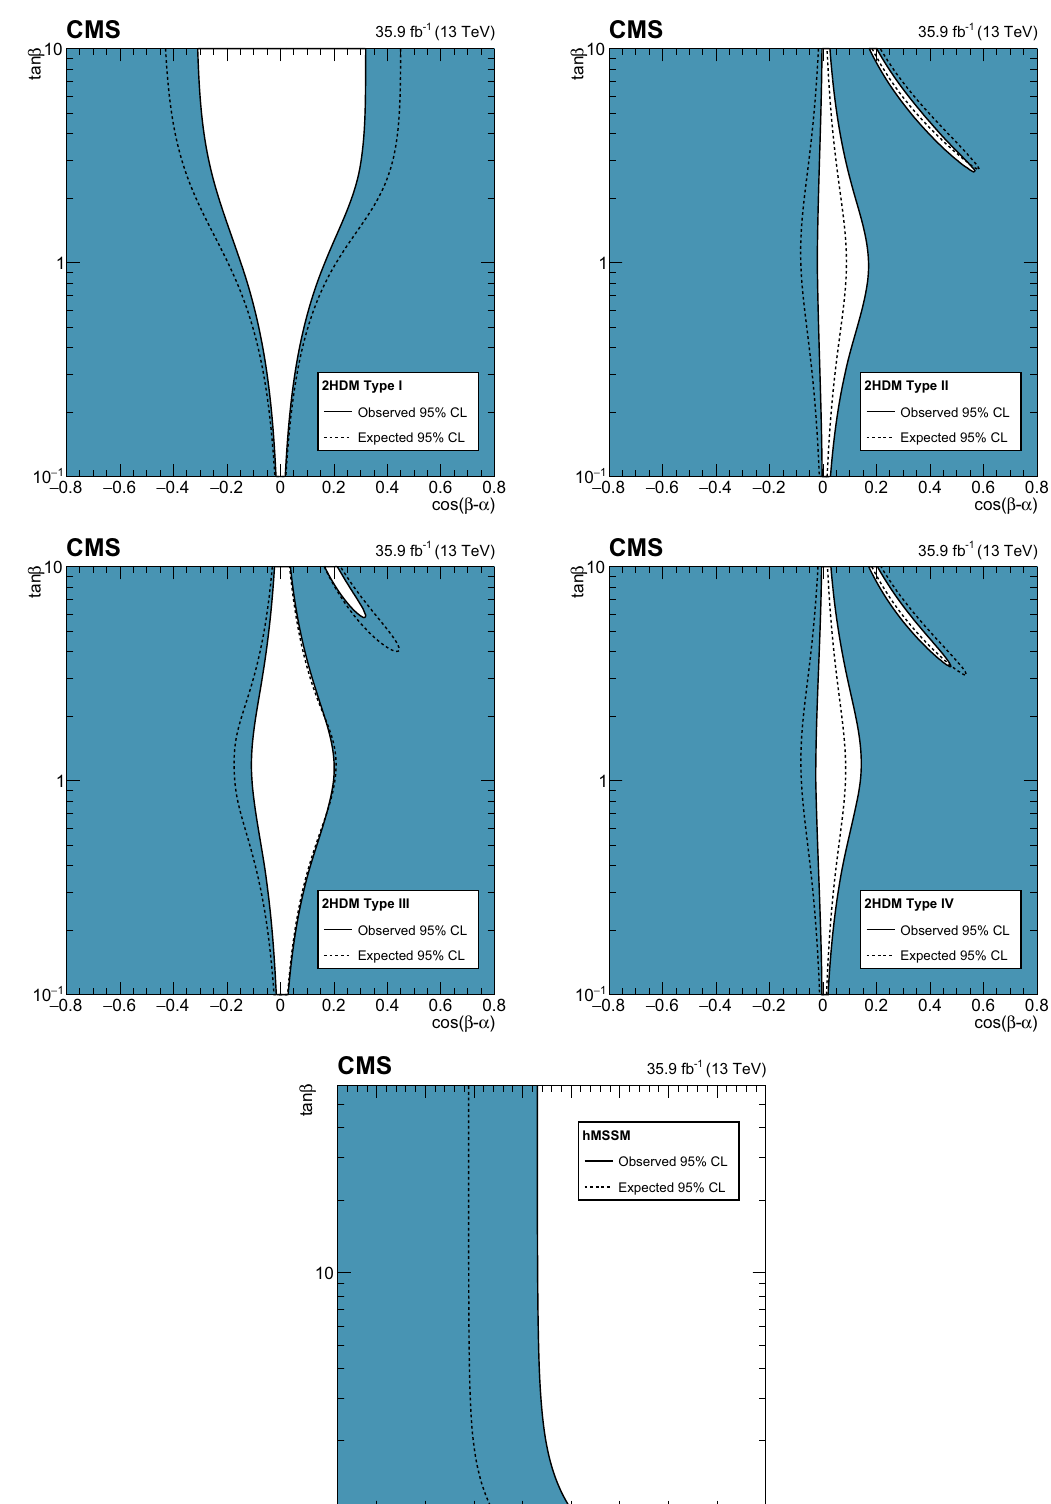
Fig. 19 Constraints in the cos (β − α) vs. tan β plane for the Types I, II, III, and IV 2HDM, and constraints in the m A vs. tan β plane for the hMSSM. The white regions, bounded by the solid black lines, in each